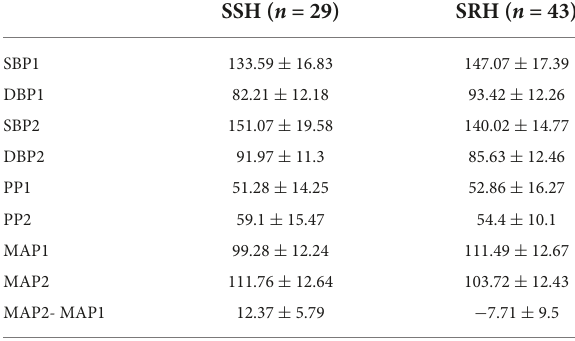
TABLE 2 NS-loading test in salt-sensitive hypertension (SSH) and salt-resistant hypertension